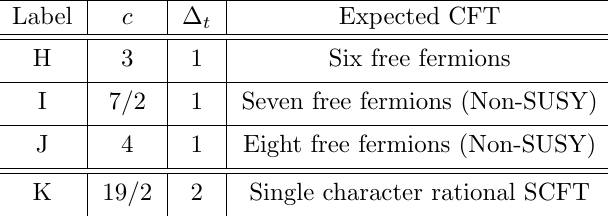
Table 5 . List of theories on the numerical boundary of (cid:12)gure 10, when the conserved currents with j (cid:21) 1 included in the 2